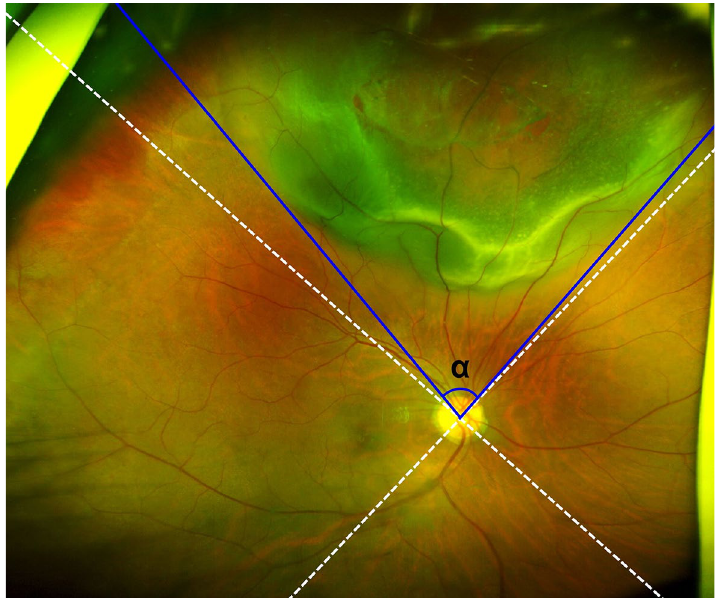
Figure 2. Definition of the location and extent of retinal detachment. The location was subdivided into superior, nasal, inferior, or temporal quadrants based on the imaginary lines centered on the optic nerve head (dotted lines). The extent was defined as the angular distance between lines connecting the optic nerve head center and the margins of detached retina (blue solid lines, angle